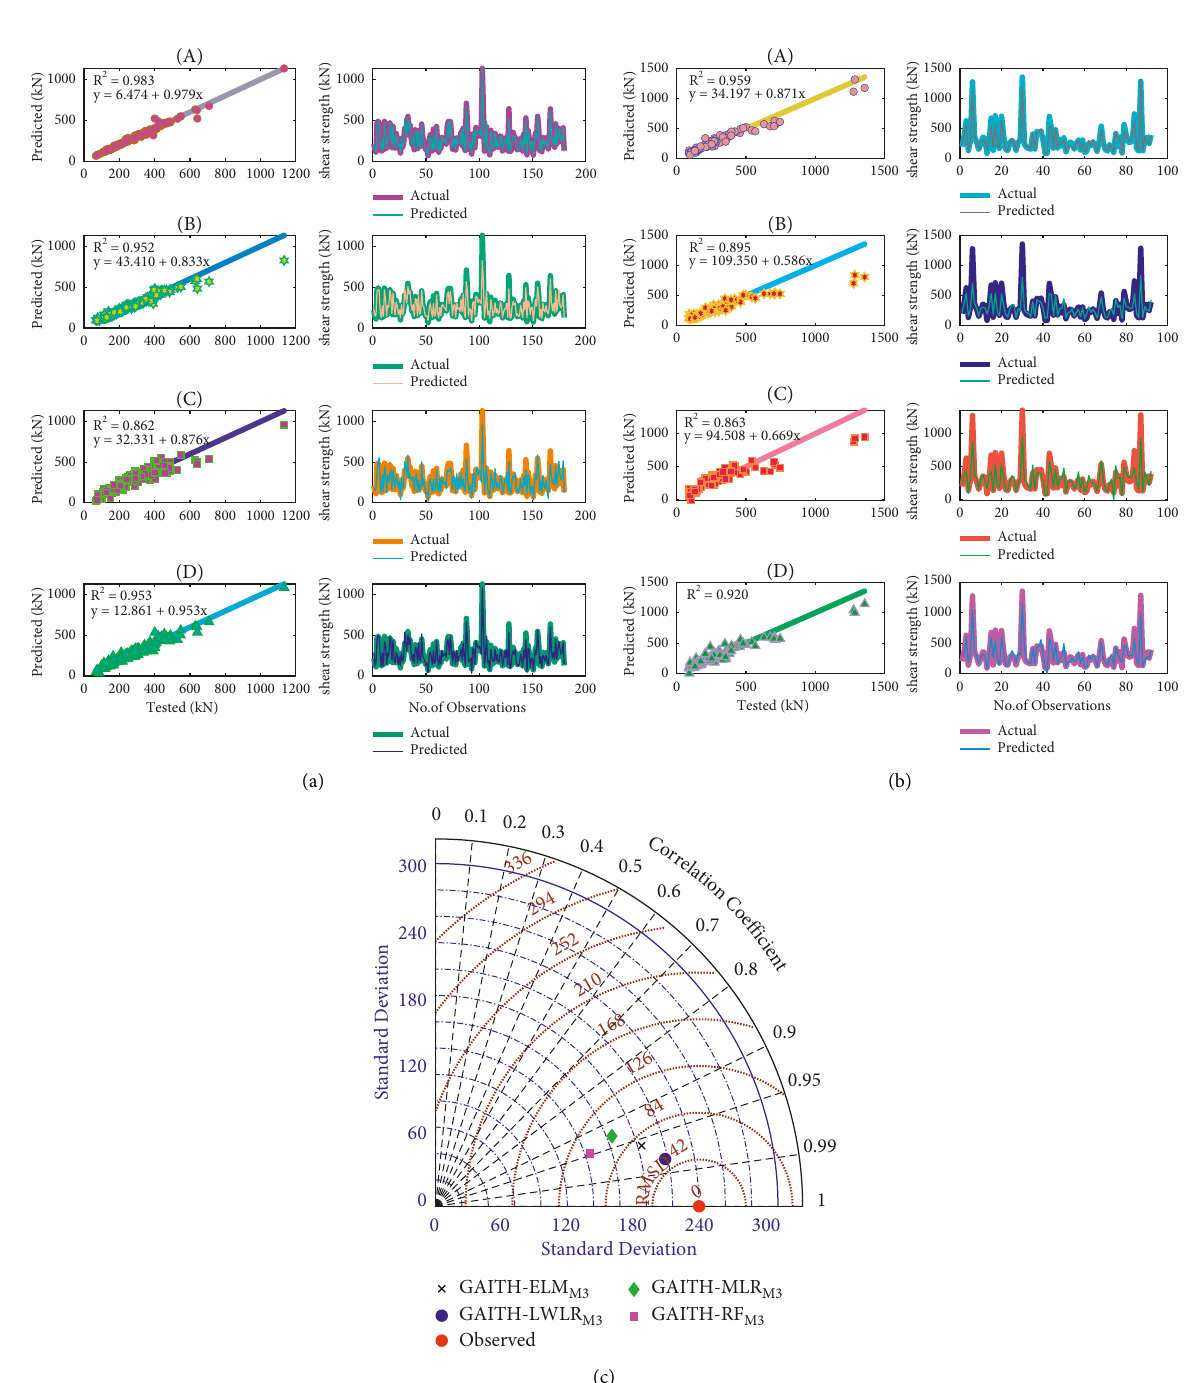
, GAITH − RF , GAITH − M 3 M 3